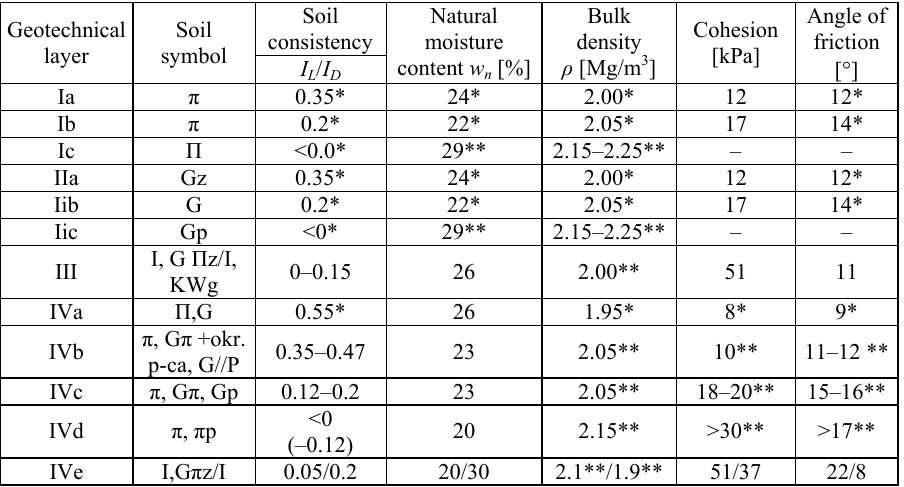
Fig. 6. The arrangement of geological bore-holes and the course of geological and engineering cross-section Table 1. The arrangement of geotechnical parameters of the